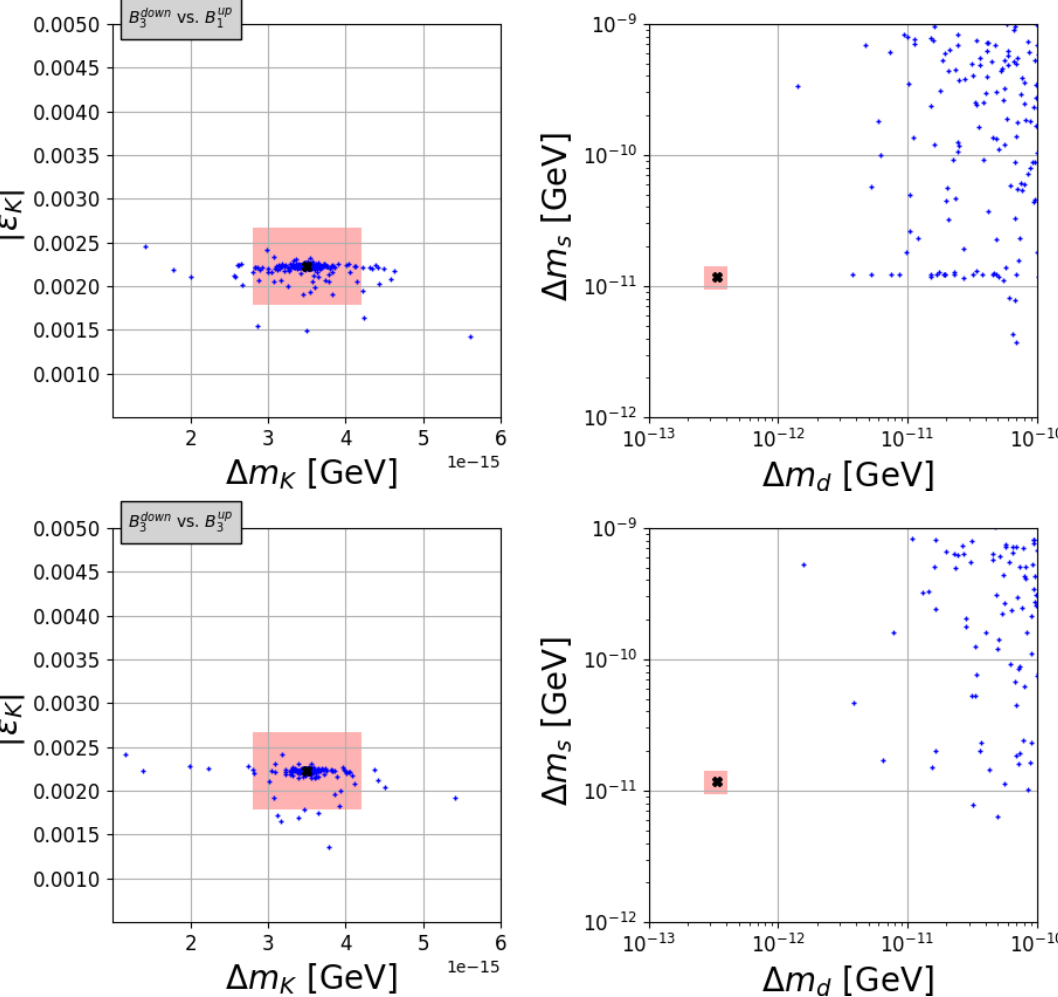
Figure 6 . Meson sector predictions for ( B 3 ; B 1 ) (upper) and ( B 3 ; B 3 ) (lower) scenarios.